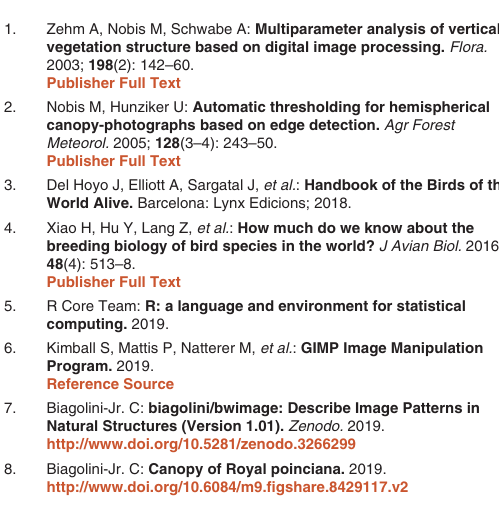
Figshare: Image from a vegetation plot of 30×100cm. https://doi.org/10.6084/m9.figshare.8429882.v2 9